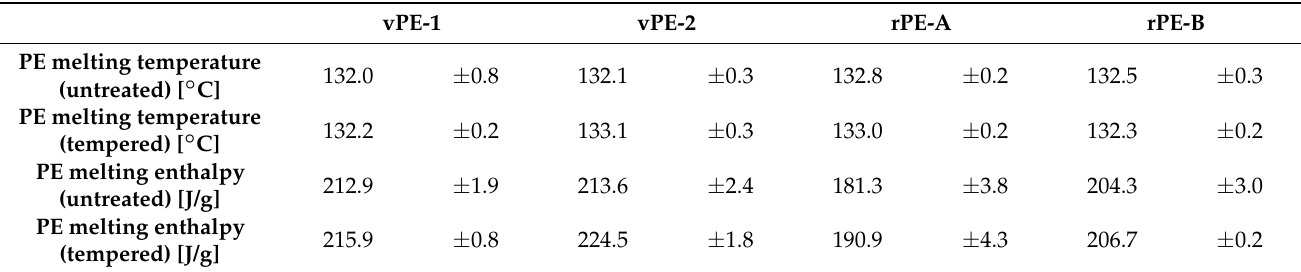
Figure 6. Averaged DSC thermograms (three measurements for one curve) from samples cut from untreated and tempered bars used to produce CRB specimens. Curves are stacked for better visibility. Table 1. PE melting temperatures and enthalpies for untreated and tempered bars cut from pressed plates intended for CRB specimen production.